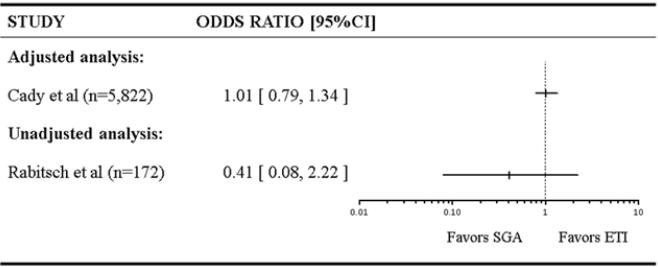
Figure 2c. Associations of pre-hospital advanced airways [endotracheal intubations (ETI) versus supraglottic airways (SGA)] with survival to hospital discharge.